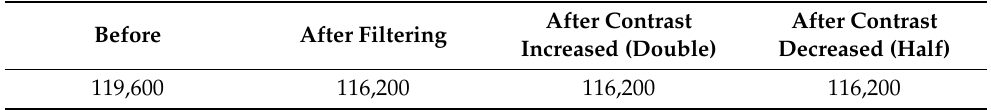
Table 4. Distribution of all fire images in the dataset.